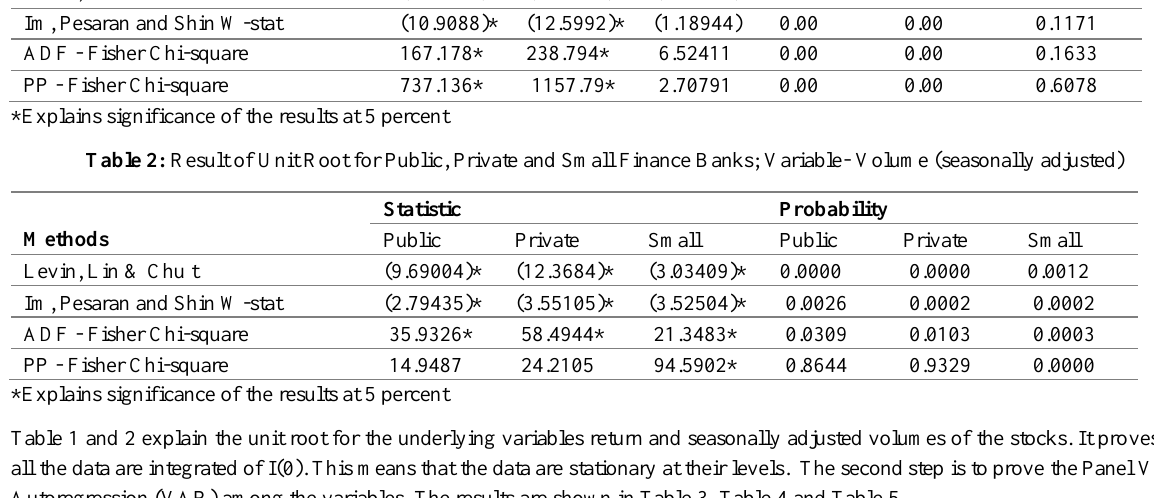
Table 1: Result of Unit Root for Public, Private and Small Finance Banks; Variable- Return